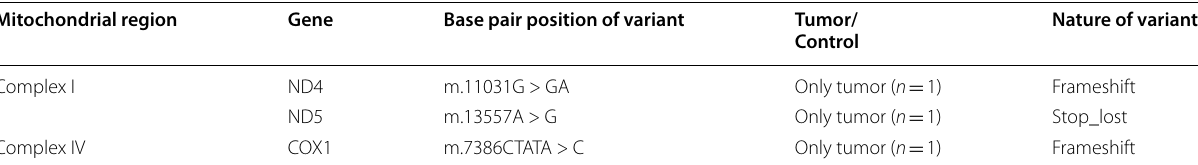
Table 3 List tabulating the new LOF variants in different regions (column 1) encoding genes (column 2) of the mitochondrial genome at various base positions (column 3) and their presence/absence and in the number of tumor and control samples (column 4)